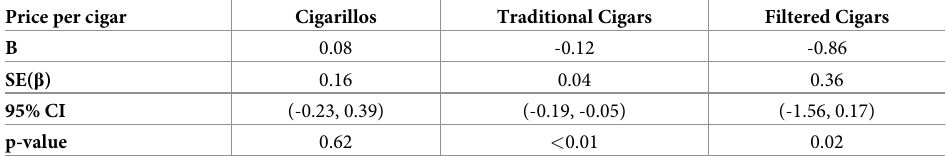
Table 3. The association between price per cigar and the average number of cigars smoked per